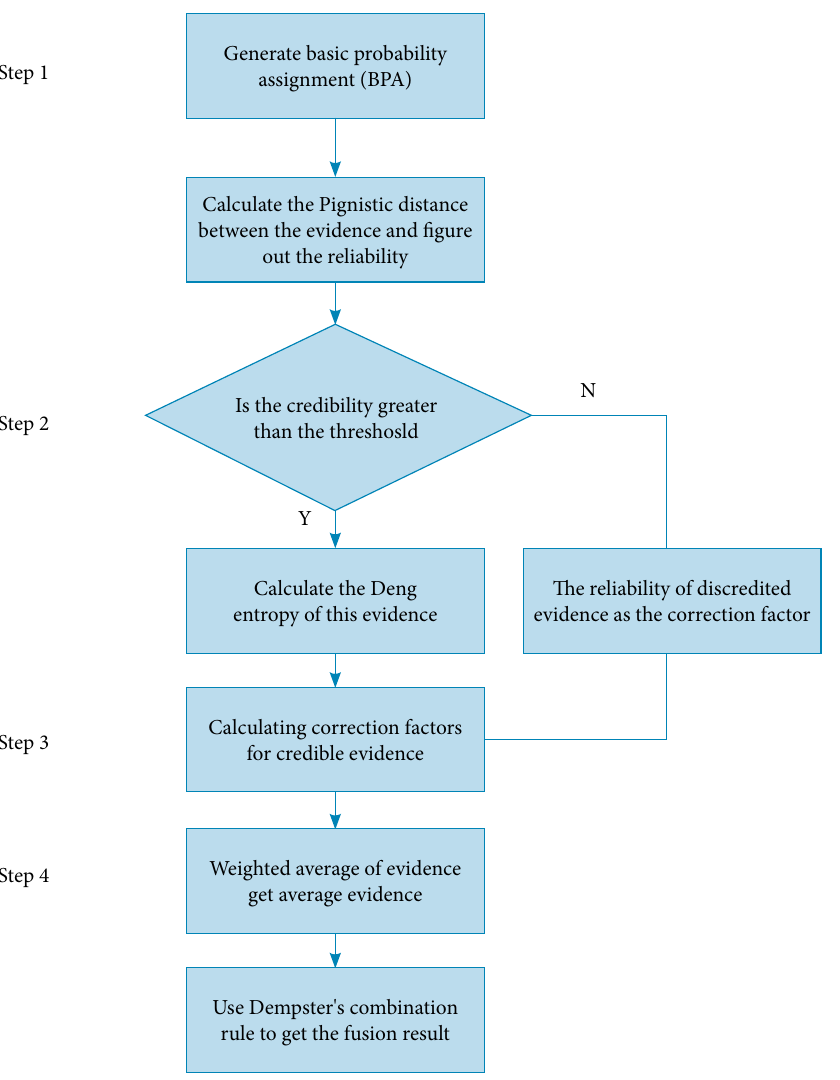
Figure 1. Flow chart of the proposed